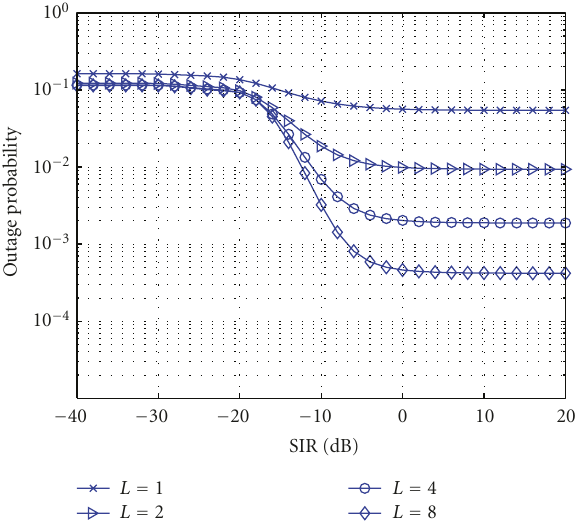
Figure 12: Outage probability of a DS/FH system, impact of the number of multipath, the number of antenna elements M = 2, processing gain G DS = 50, the number of users K = 40, the number of interferers is J 1 = 1, J 2 = 2, J 3 = 3, duty cycles of interferes are ρ 1 = ρ 2 = ρ 3 = 0 . 2, SNR Γ N = 100 dB, the number of hopping channels N = 10, decay factor δ = 0, and protection ratio r th = 3